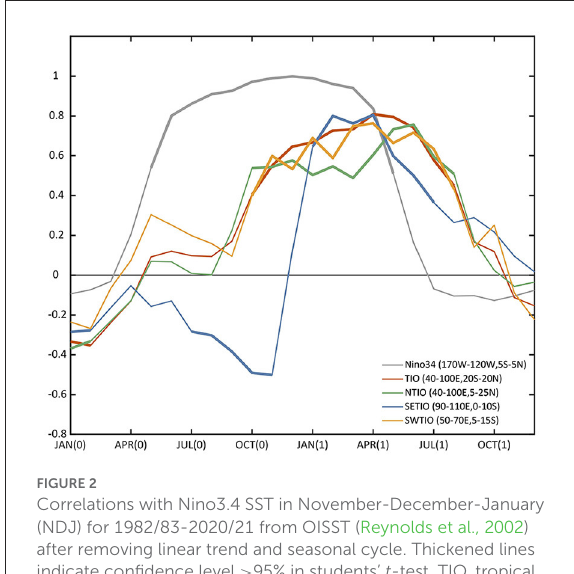
FIGURE2 Correlations with Nino3.4 SST in November-December-January (NDJ) for 1982/83-2020/21 from OISST (Reynolds et al., 2002) after removing linear trend and seasonal cycle. Thickened lines indicate confidence level > 95% in students’ t- test. TIO, tropical Indian Ocean; NTIO, north tropical Indian Ocean; SETIO, southeast tropical Indian Ocean; SWTIO, southwest Indian Ocean.